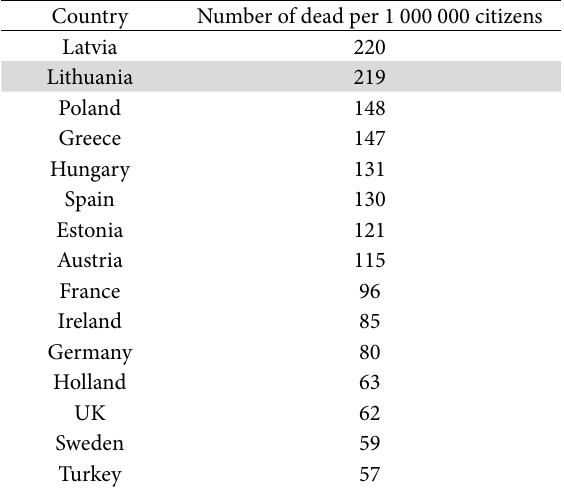
Table 1. The figures for the people killed in car accidents